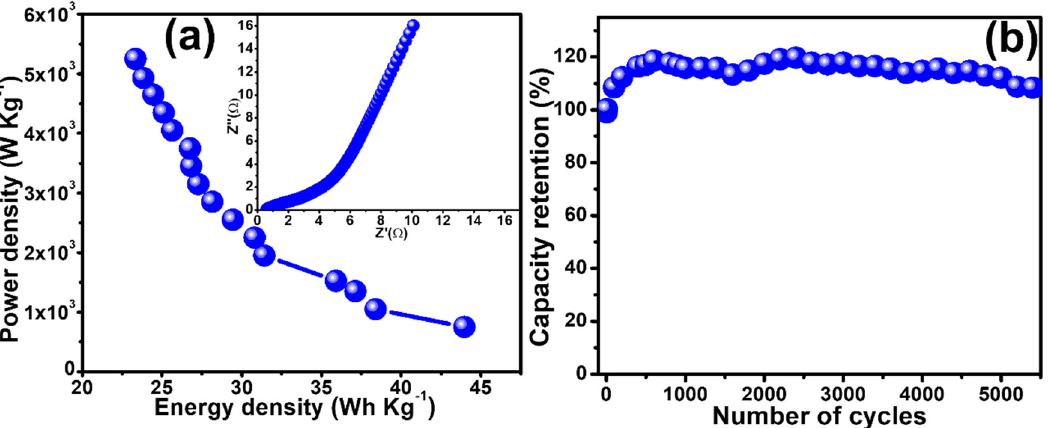
Figure 9. ( a ) Energy density vs. power density graph and inset Figure 9a show the Nyquist plot of EIS studies of assembled device, ( b ) stability studies of the fabricated device, Ag/GN@PPy − Ni(OH) 2 //AC. Table 1. Nanocomposite-based electrode materials for energy storage